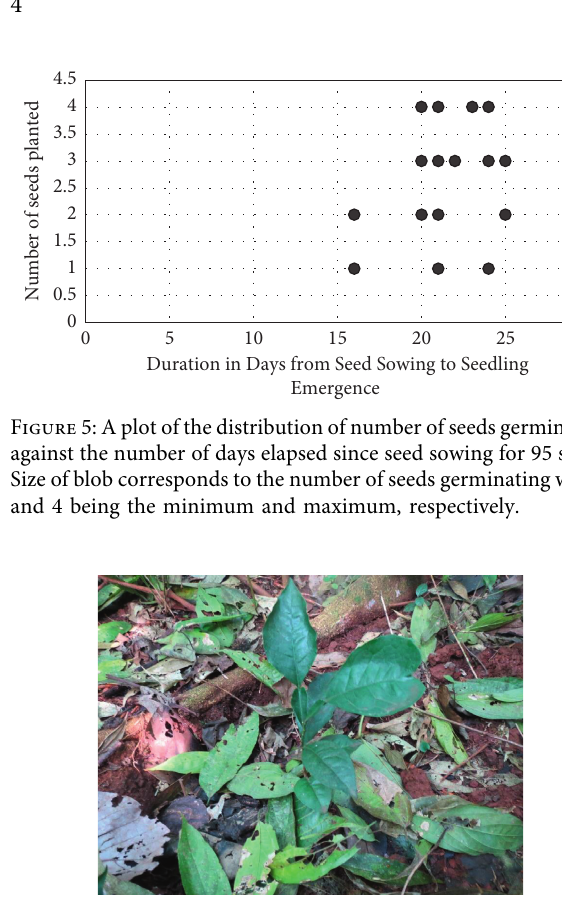
Figure 6: Seedling surviving in forest 15 months after